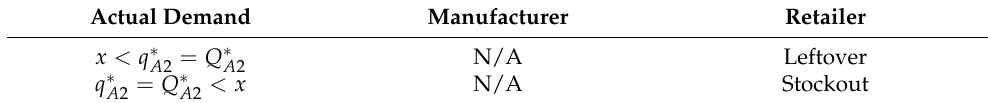
(cid:0) (cid:1) r , w , q ∗ , Q ∗ A 2 A 2